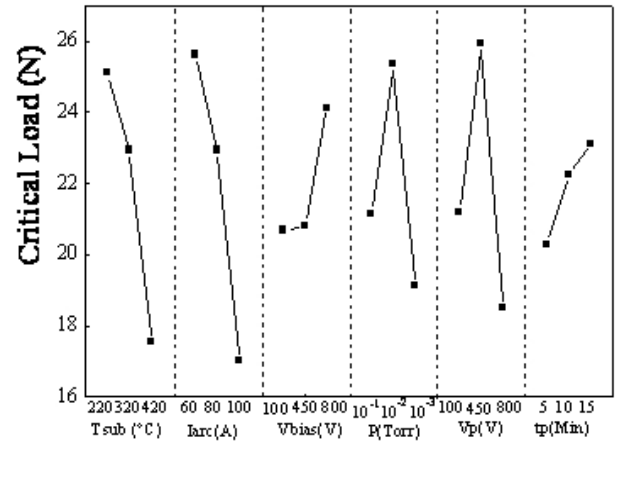
Figure 7. Response graph for the six factors vs. critical load of the scratch